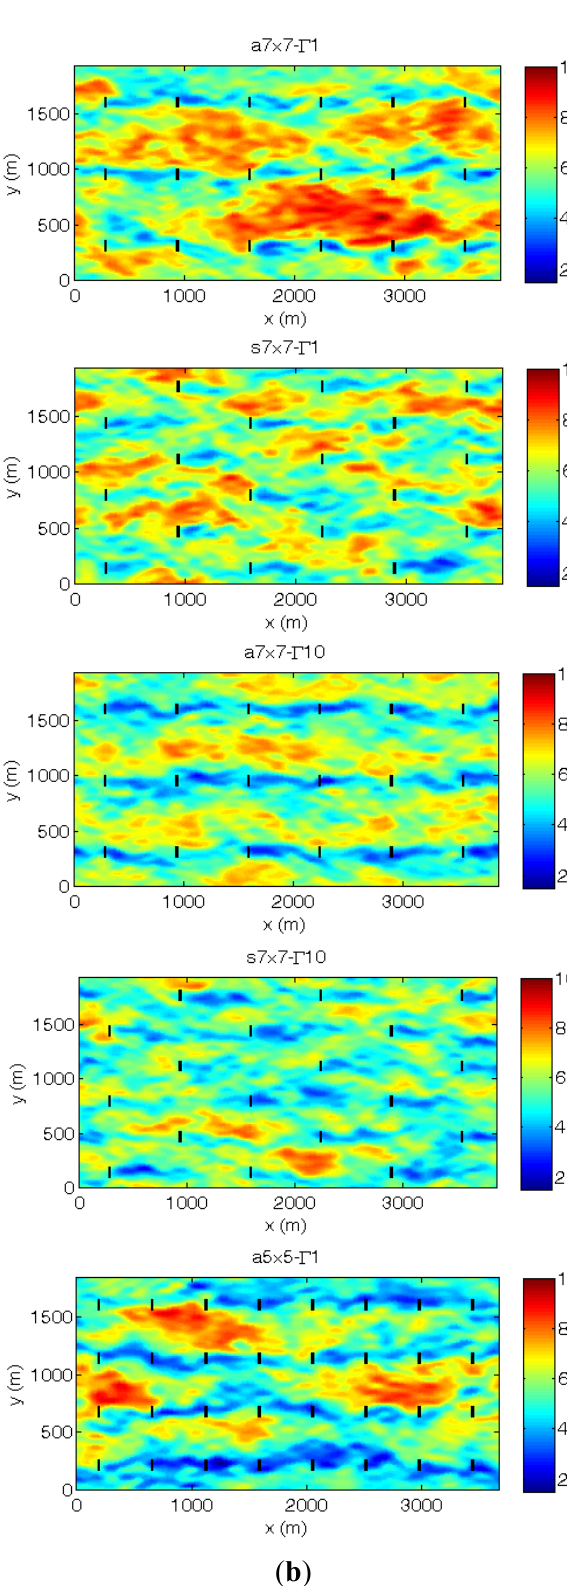
Figure 10. Contours of mean ( a ) and instantaneous ( b ) streamwise velocity (m/s) at the hub-height level for the different cases. Only a section of the domain is